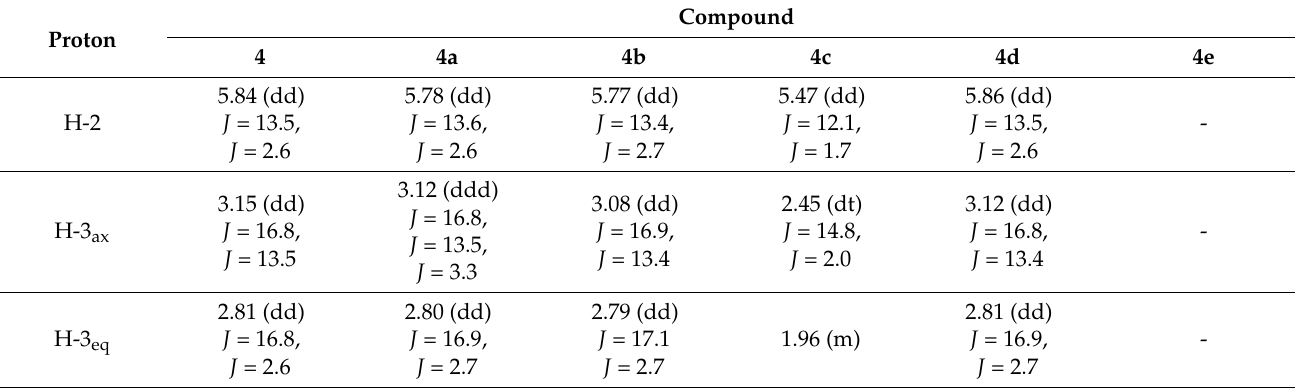
Table 1. 1 H-NMR chemical shifts δ (ppm) and coupling constants J (Hz) of 2 (cid:48) -methylflavanone ( 4 ) and products of its biotransformations 4a – 4e in Acetone-d6, 600 MHz (Supplementary Materials: Figures S2, S18, S38, S54, S72, S90).